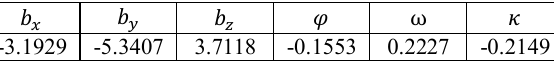
Table 2. Relative orientation parameters (pixel/degree)